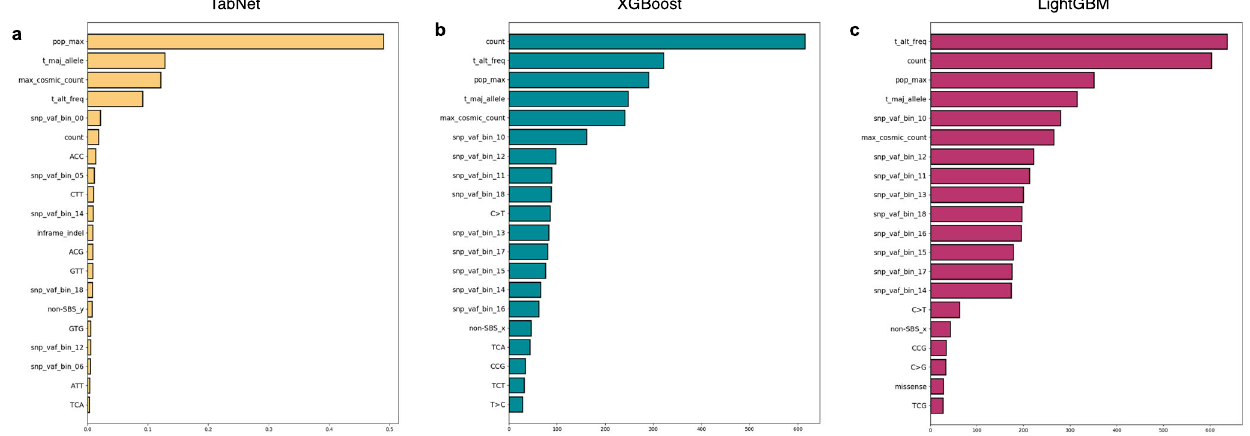
Fig. 6 Feature importance for trained tabular machine learning somatic vs germline classi fi ers. Top 20 most important features shown for a TabNet, b XGBoost, and c LightGBM. pop_max , maximum population frequency of variant across multiple germline databases; t_maj_allele , the fraction of reads containing the most supported allele at that locus in the sample; max_cosmic_count , the number of occurrences of the variant in COSMIC somatic database; t_alt_freq , the fraction of reads supporting the alternate allele; snp_vaf_bin_i , the number of informative SNPs (heterozygous SNPs common in germline databases whose VAF should inform the local copy number) in the copy-number segment with a VAF between i/20 and (i + 1)/20 where i is an integer between 0 and 19; count , the total number of variants to classify in that sample; ACC , CTT , etc , trinucleotide context; non-SBS-y , non-single-base substitution (meaning no trinucleotide context applies). The full list of 30 features and brief descriptions are included in Supplementary Table